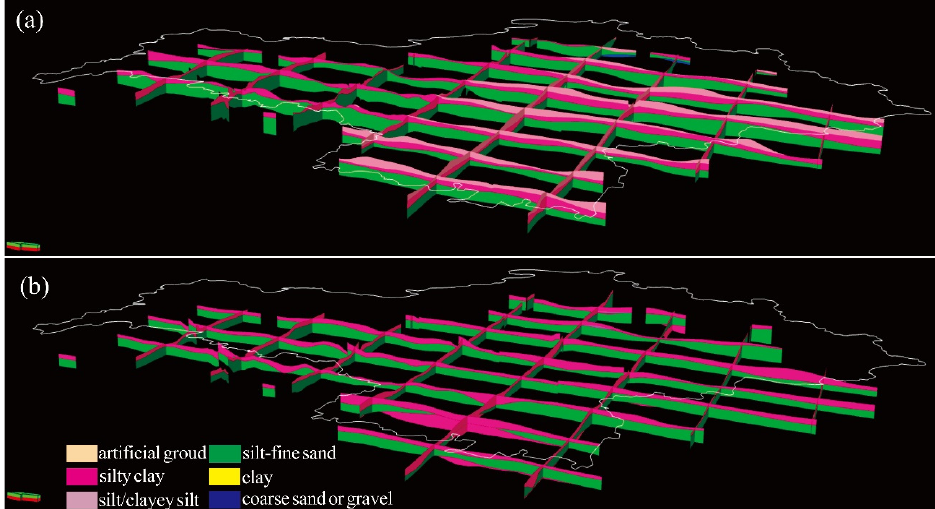
Figure 9. Distribution and thickness of geological units in the study area: ( a ) the second cyclothem; ( b ) the third cyclothem.